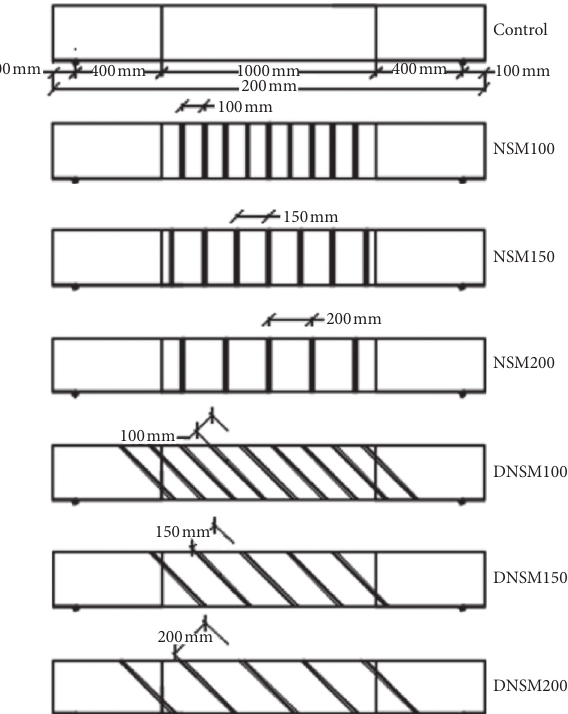
Figure 2: Strengthening of the test beams.